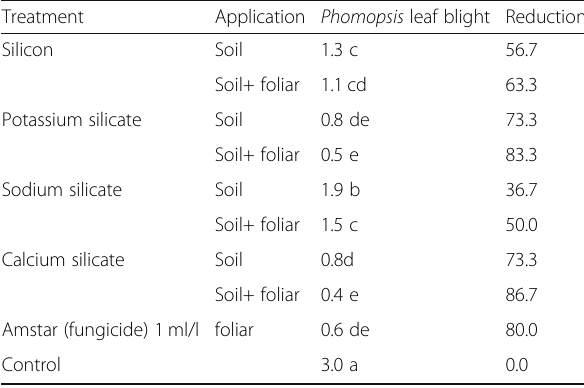
Table 2 Effect of silicon and potassium, sodium and calcium silicates, and a fungicide on Phomopsis leaf blight disease of strawberry plants under field